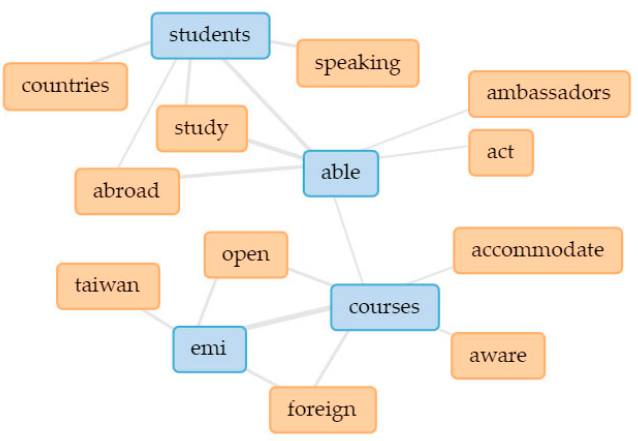
Figure 6. Interrelationships and extended links among the perceived EMI weakness.